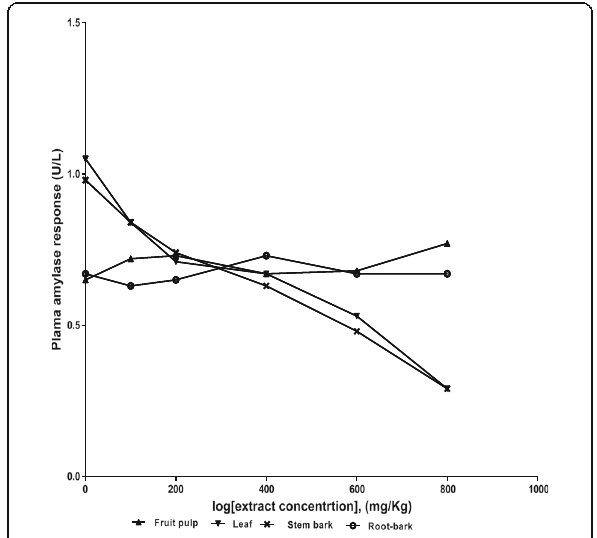
Fig. 1 Dose-response line plot of the influence of Annona muricata